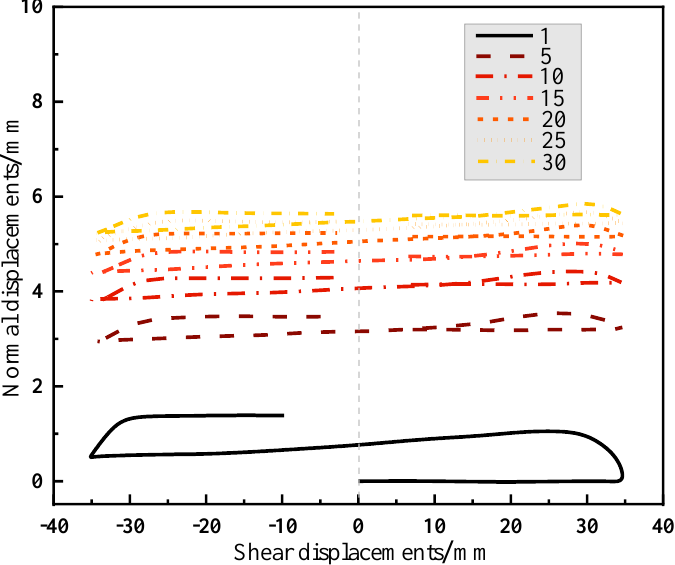
Figure 10. Normal displacement – shear displacement curve with different numbers of cycles.